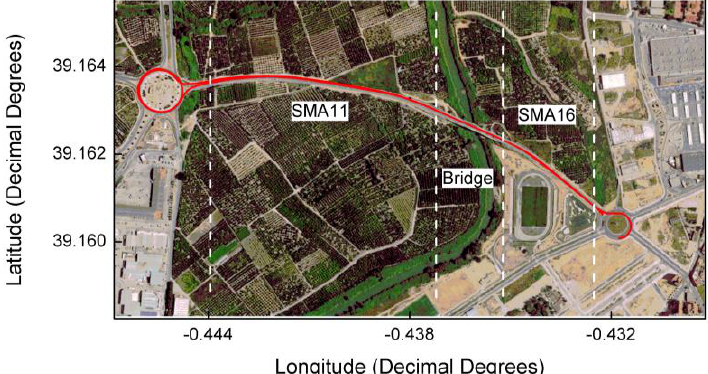
Figure 1. Experimental test tracks near Alzira (Valencia), showing the GPS coordinates of the studied test sections of stone mastic asphalt mixtures SMA11 and SMA16.